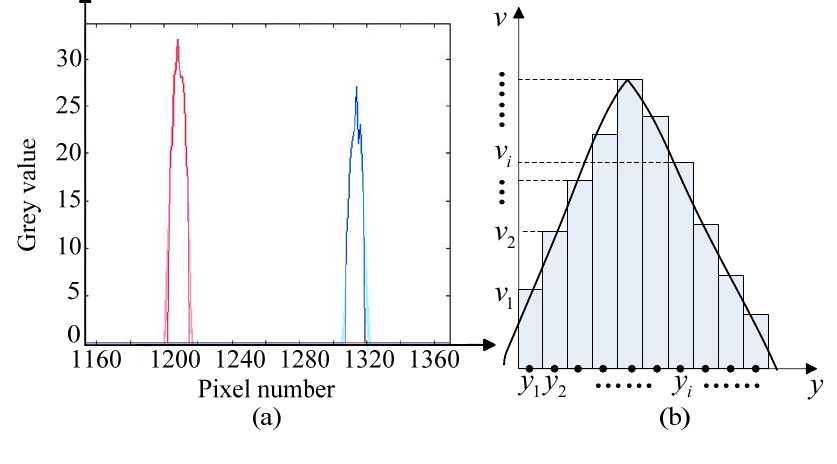
Figure 7. Illustration of the centroiding algorithm. (a) data plot of two sun spots detected by CCD; (b) abstract of sun